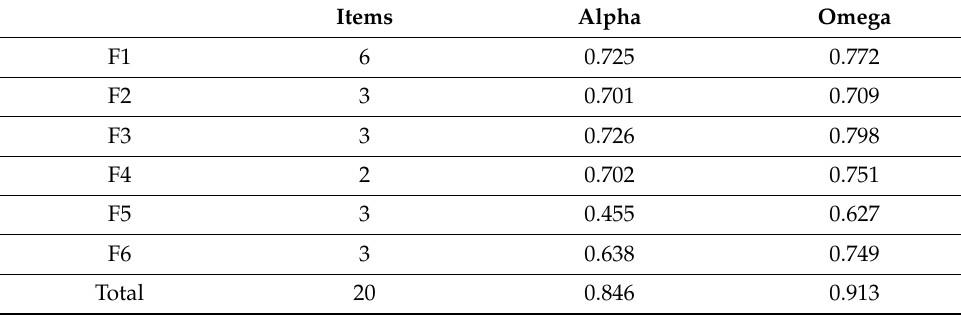
Table 7. McDonald’s omega and Cronbach’s alpha coefficients.